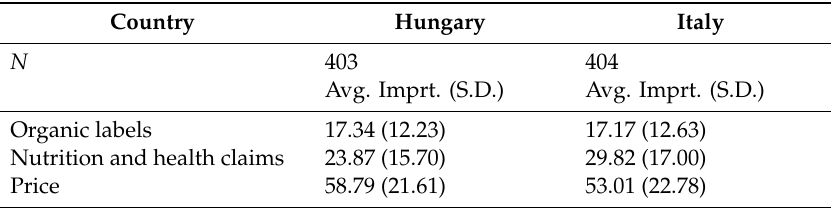
Table 3. Attribute importance scores for Hungary and